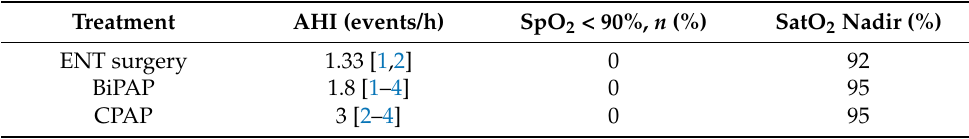
Table 5. PSG parameters during the post-treatment